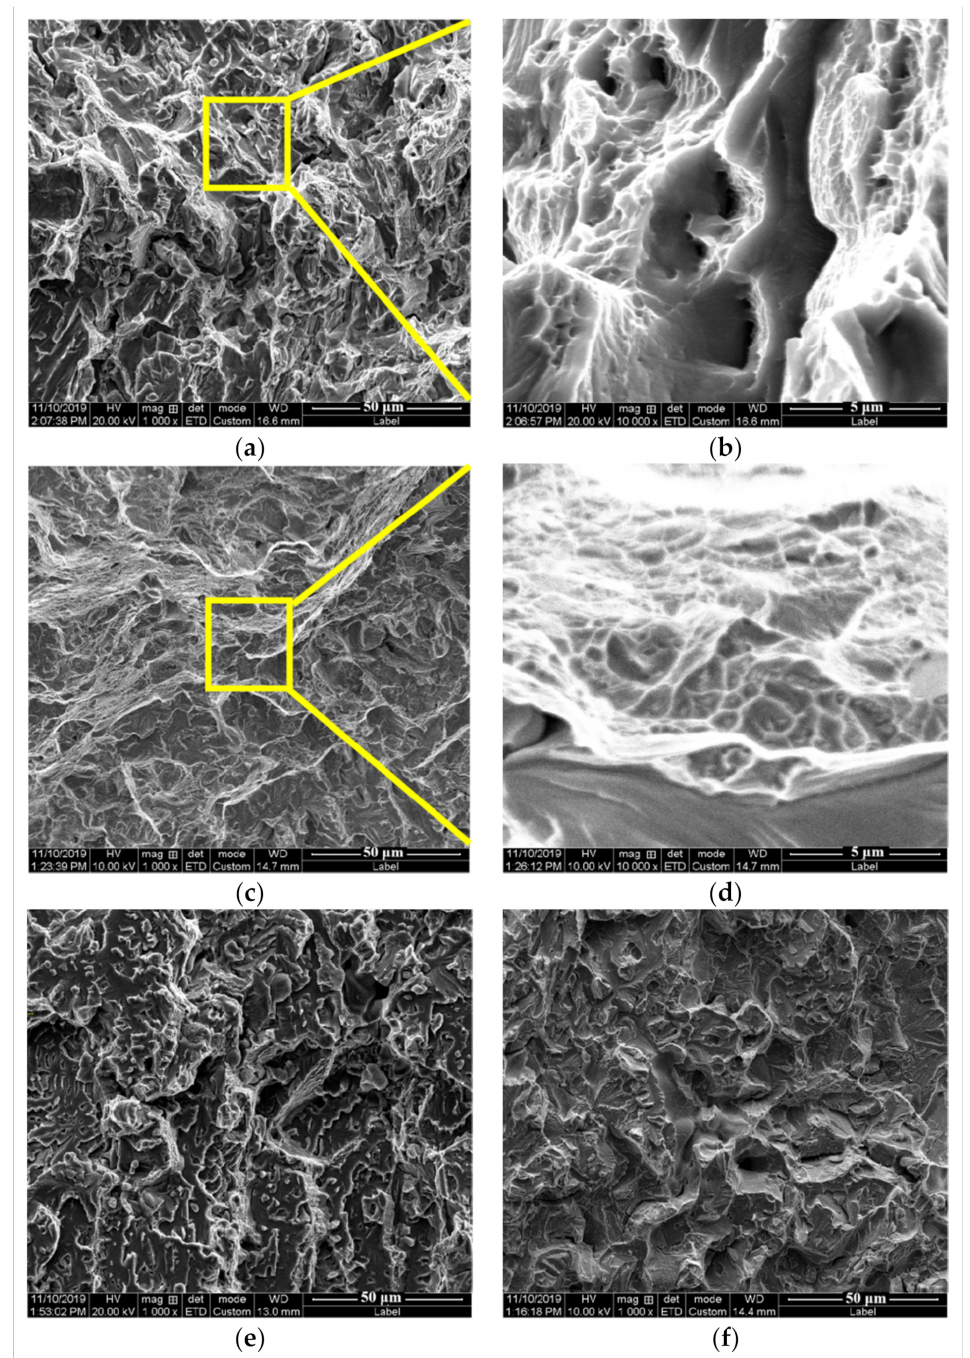
Figure 12. SEM photograph of Fe-25Mn- x Al-8Ni-C alloy in situ tensile fracture, ( a ) 10 wt.% Al, 1000 × ; ( b ) 10 wt.% Al—local enlarged, 10,000 × ; ( c ) 11 wt.% Al, 1000 × ; ( d ) 11 wt.% Al—local enlarged, 10,000 × ; ( e ) 12 wt.% Al, 1000 × ; ( f ) 13 wt.% Al, 1000 ×